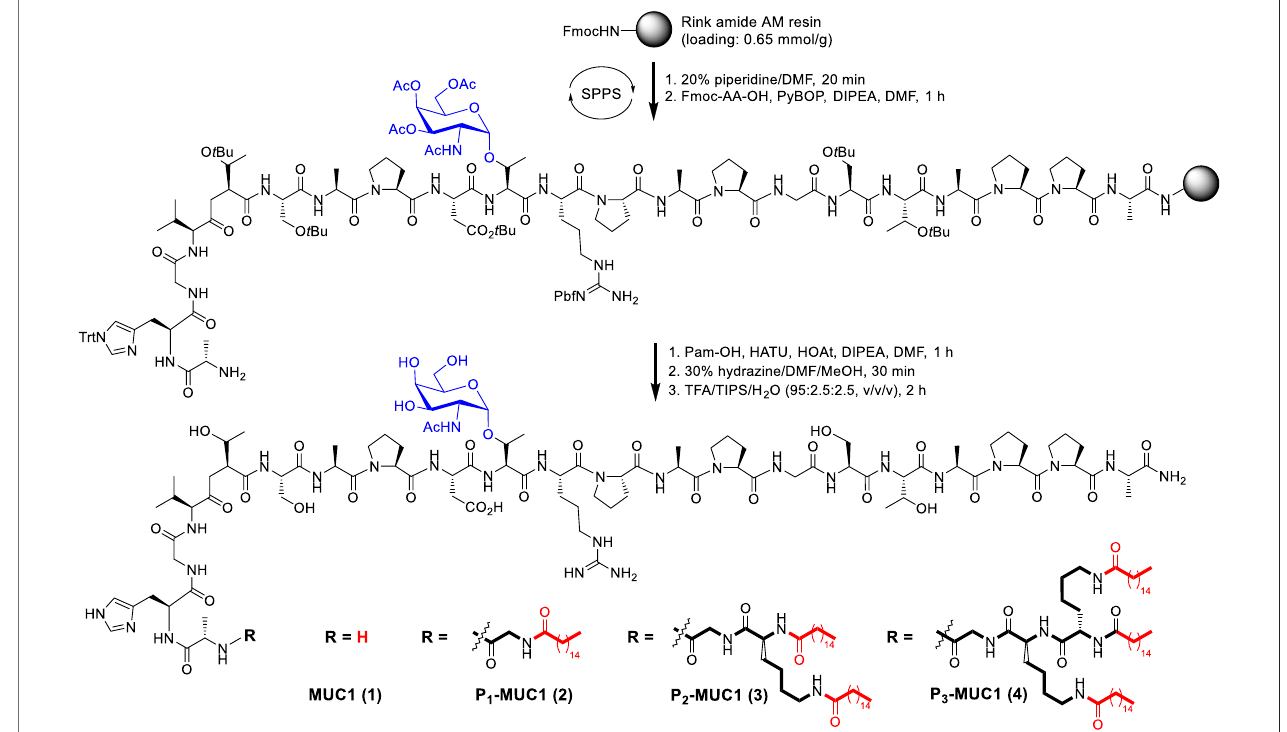
SCHEME 1 | Synthesis of MUC1 glycopeptide and lipoglycopeptides by solid phase peptide synthesis (SPPS).